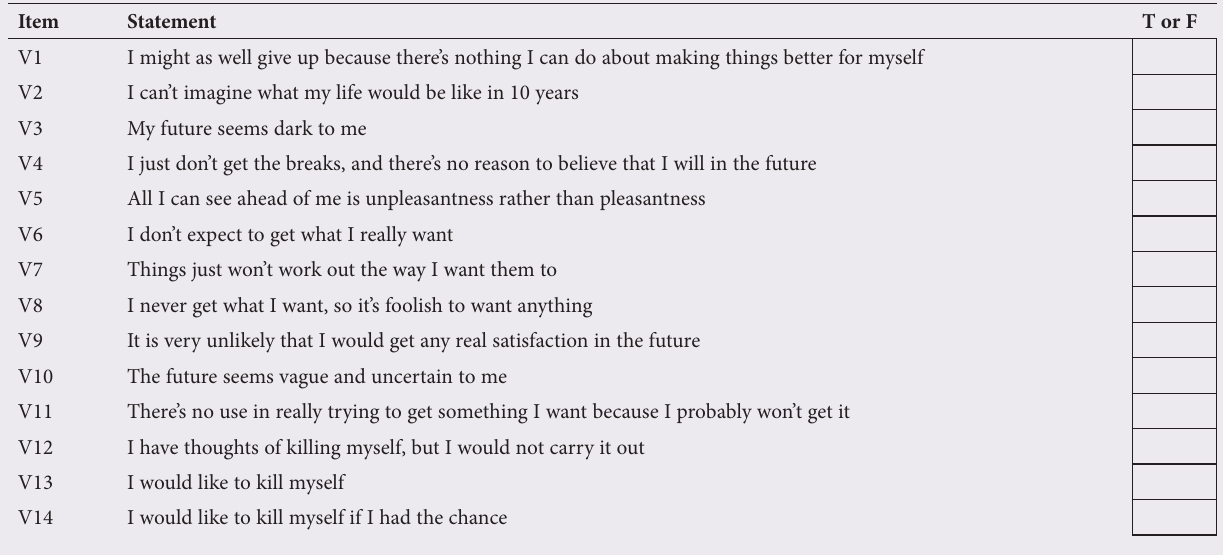
Table 1. Suicide risk screening scale This questionnaire consists of 14 statements (sentences). Please read the statements carefully one by one and answer them. If the statement describes your attitude for the past week, including now, write ‘T’ in the block provided. If the statement is false for you, write ‘F’ in the